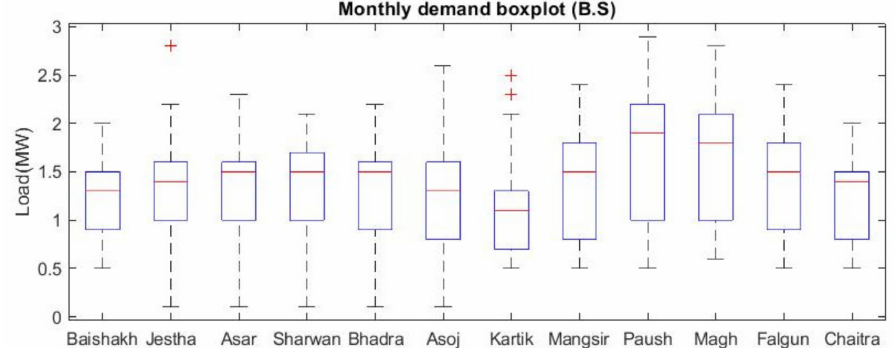
Figure 2. Boxplot of electricity demand for each month